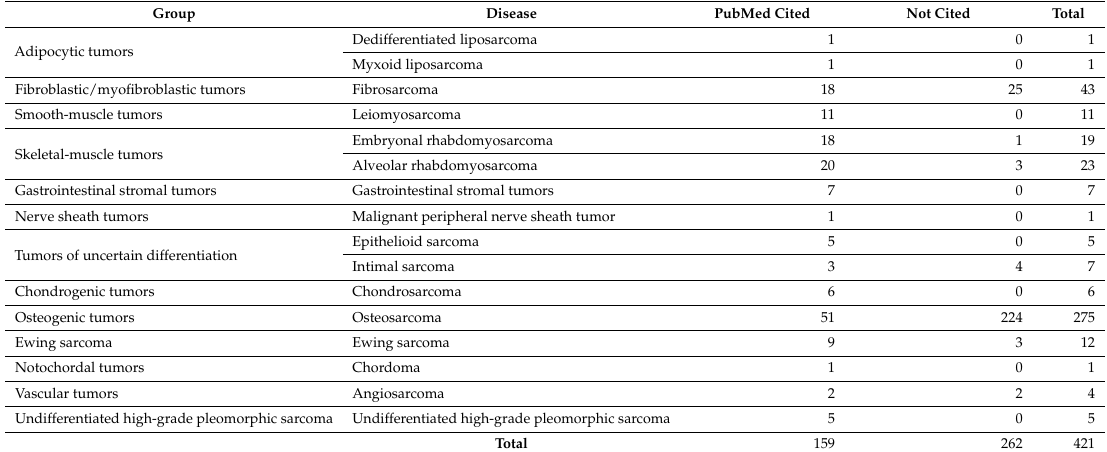
Table 5. PubMed citation of WHO classified and modified cell lines.